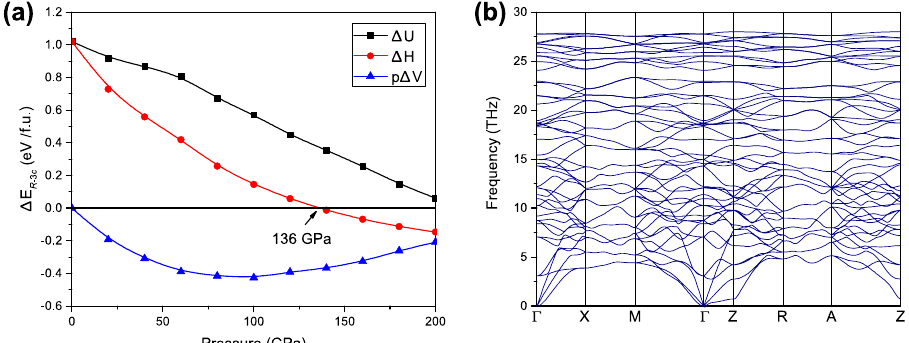
Figure 1. Enthalpy curves and phonon dispersion of the P 4 2 212 structure . ( a ) The difference in enthalpy, internal energy U , and the pV term between the P 4 2 2 1 2 structure and the R -3 c structure per formula unit as a function of pressure. ( b ) Calculated phonon dispersion of the P 4 2 2 1 2 structure at 140 GPa.